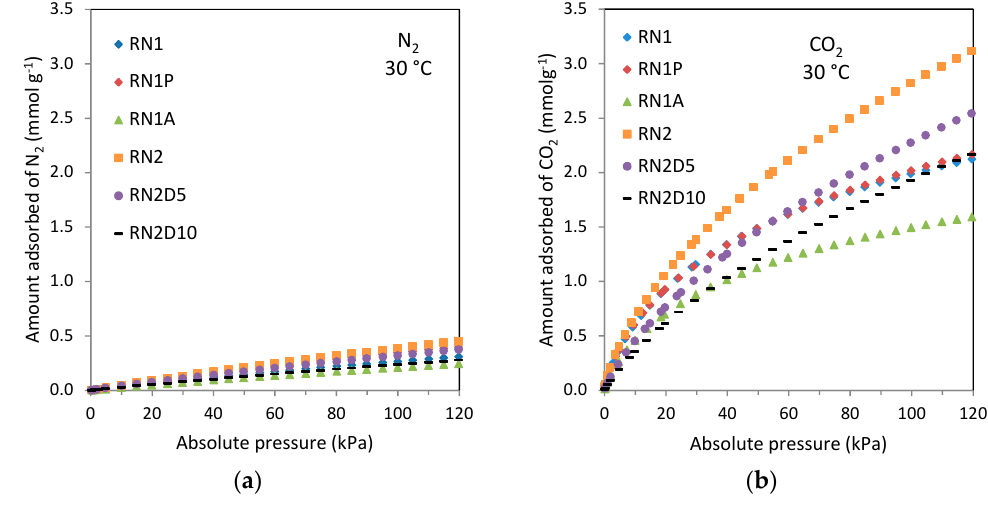
Figure 4. Equilibrium adsorption isotherms of: ( a ) N 2 and ( b ) CO 2 at 30 °C of carbons RN1, RN1P, RN1A, RN2, RN2D5, and RN2D10.